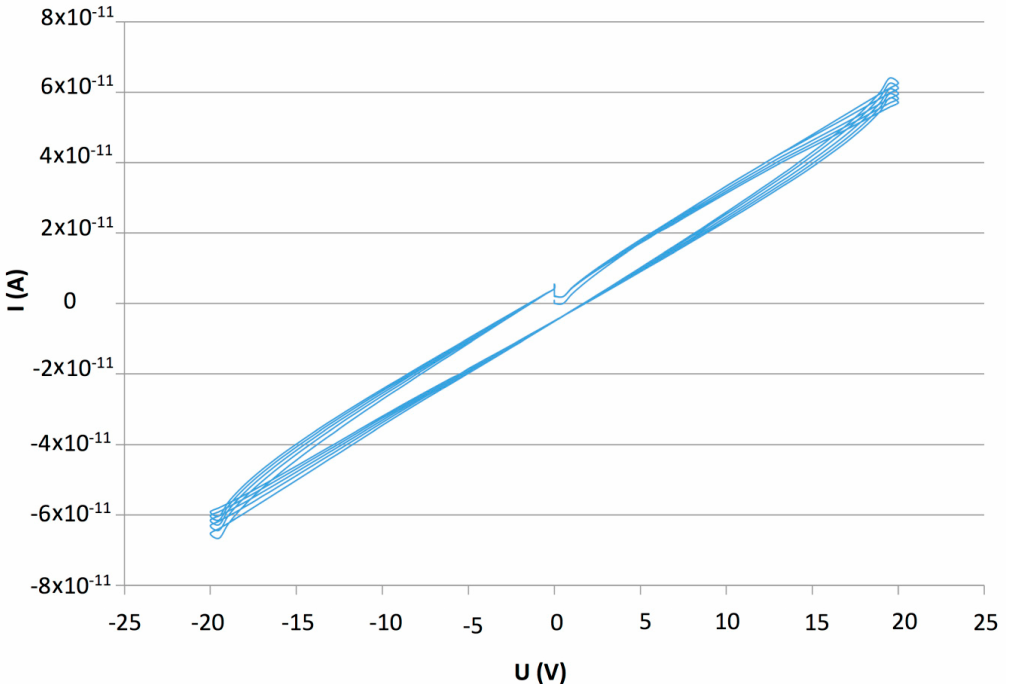
Figure 6. I-V characteristic of the (PDDA/s-CoPc)